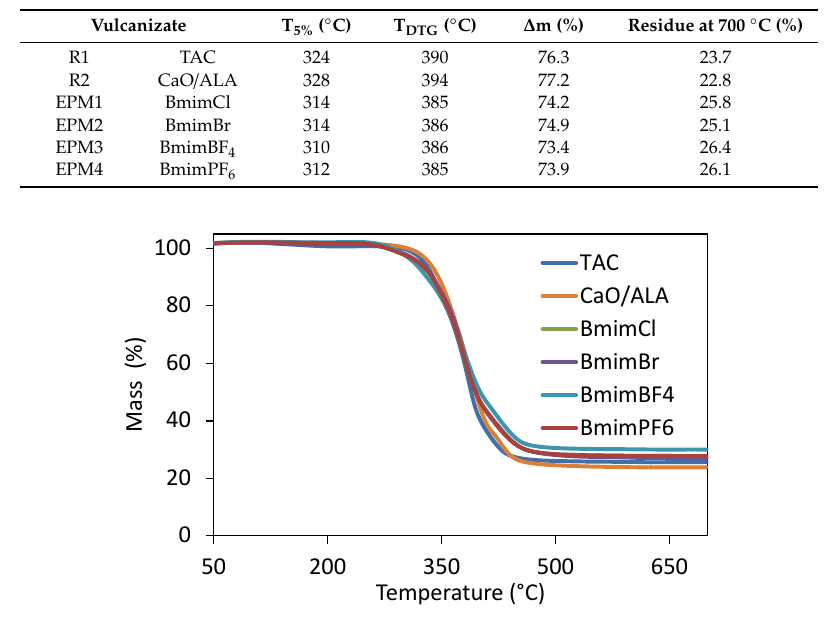
Figure 13. TG curves of EPM vulcanizates.